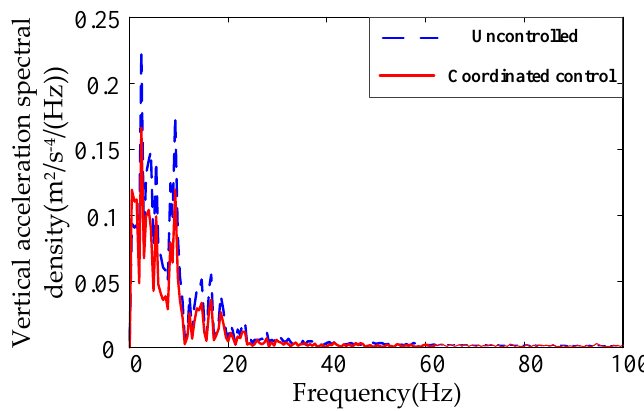
Figure 25. Vehicle vertical acceleration under the steering condition.